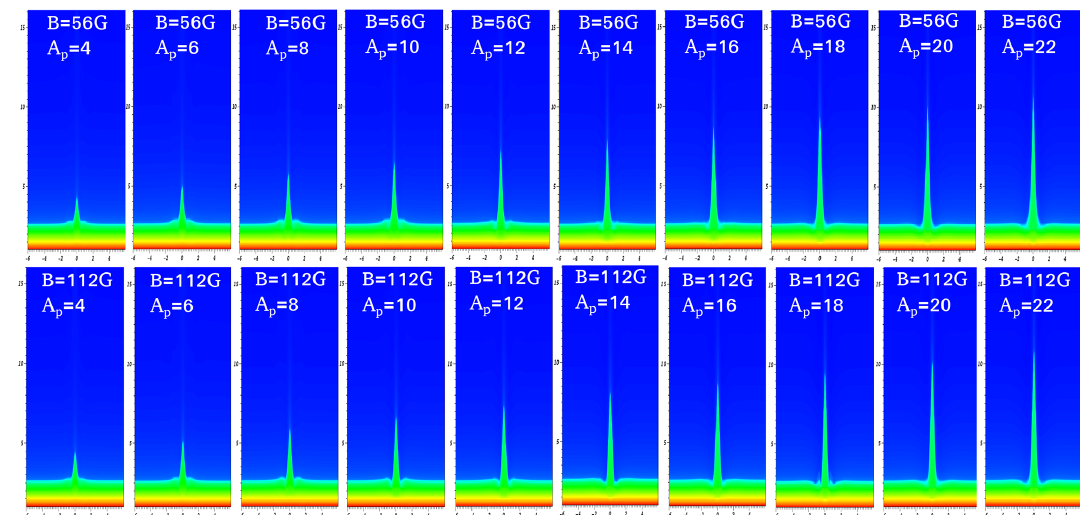
Figure 6. Evolution of the plasma jets at different pressure pulses at two different magnetic field strengths, B = 56 gauss and B = 112 gauss. The mosaic diagram shows the maximum height of the evolved jets at different pressure pulses, e.g. A p = 4–22. The horizontal ( x ) and vertical ( y ) axes are shown in megametres (Mm).